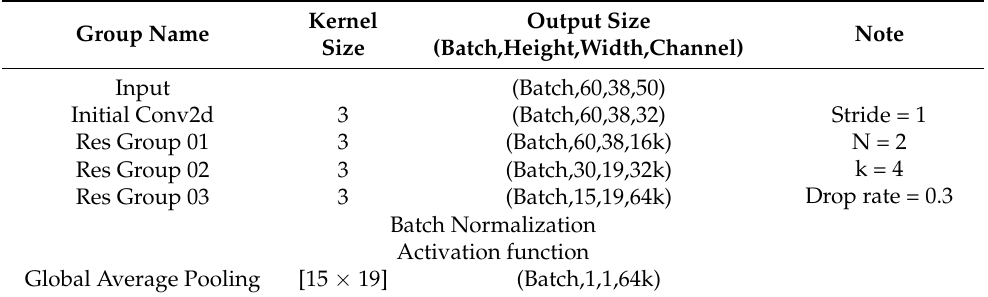
Table 2. Modified Wide Resnet